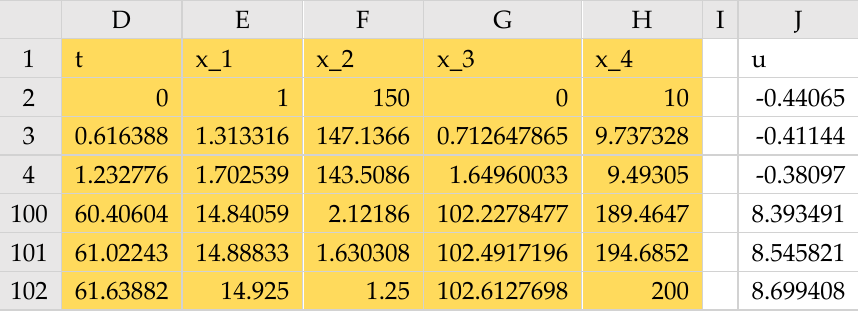
Figure 24 . Partial listing of the converged IVP solution and control values of problem 3.4.